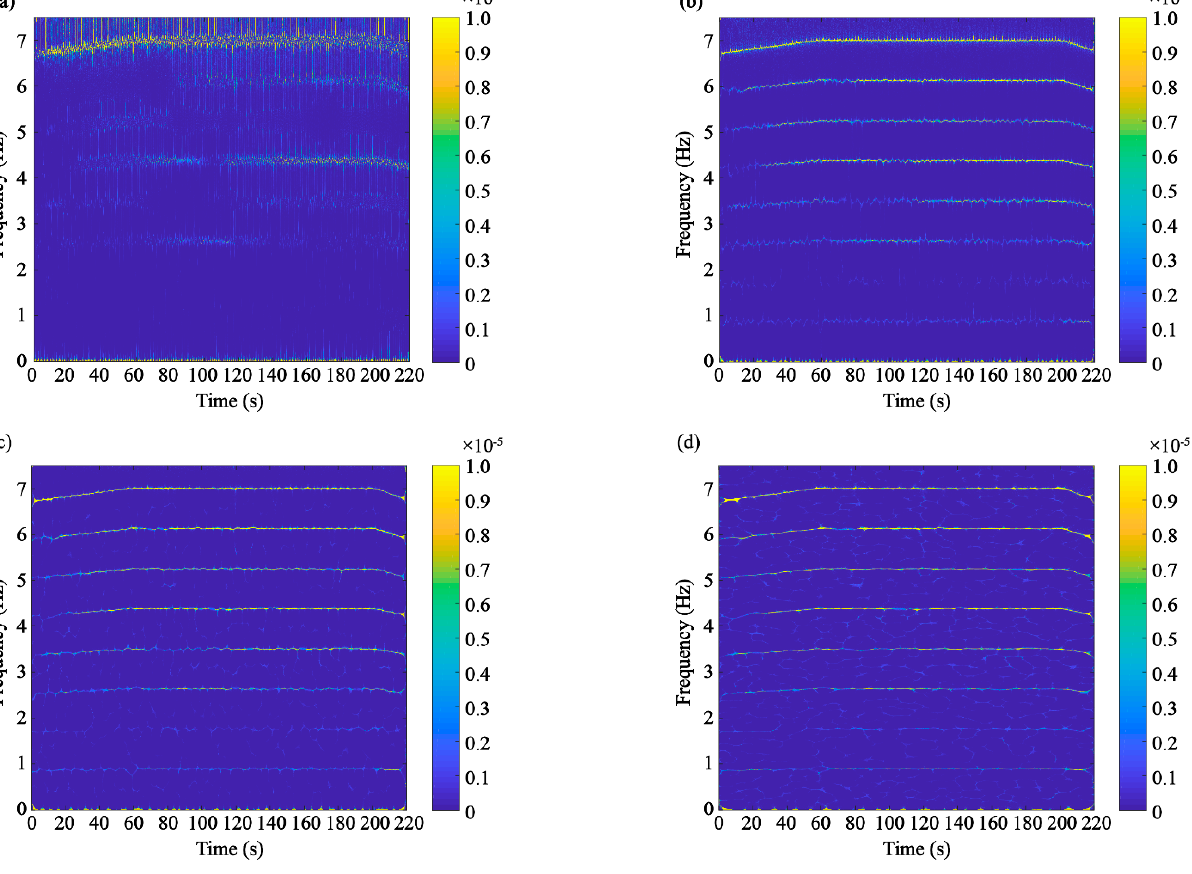
Figure 6. Time-frequency reassignment spectrogram with window function length of ( a ) 64, ( b ) 128, ( c ) 256, and ( d ) 512, respectively.